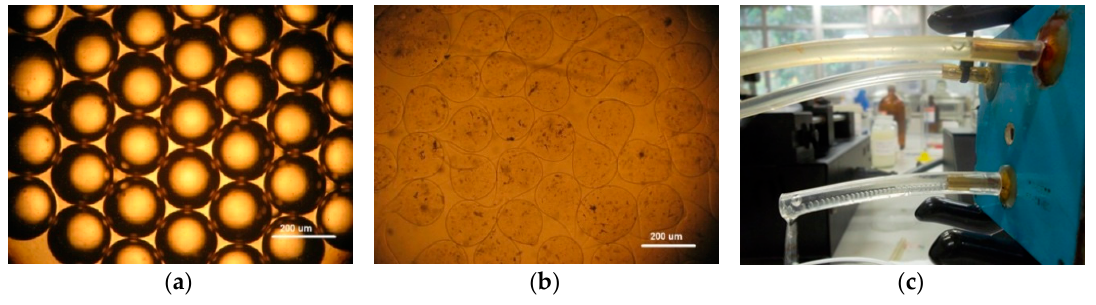
Figure 4. Sodium alginate microparticles: ( a ) sodium alginate droplets before ionic gelation, ( b ) sodium alginate microparticles after ionic gelation, and ( c ) the 3D coaxial device in operation. White bar scale of 200 μ m.